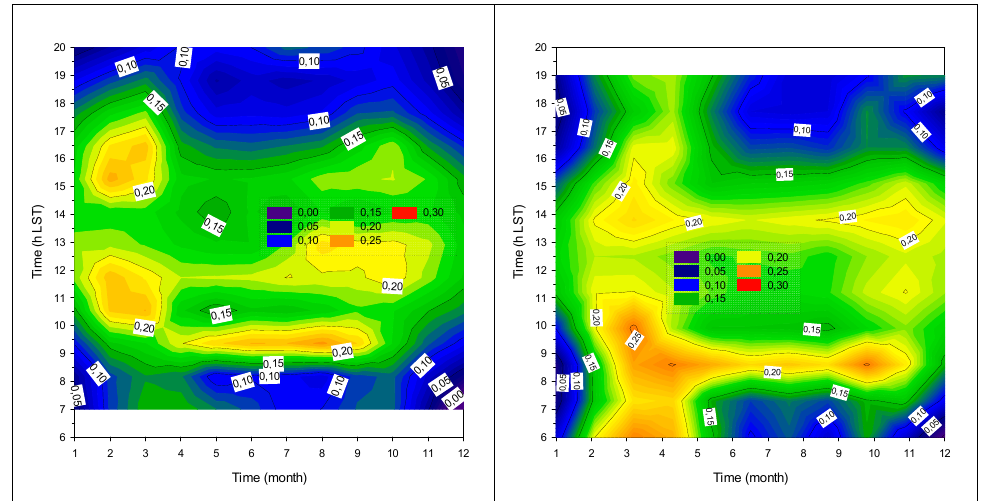
Figure 7. Month-hour diagrams of the T UM values in TATY under clear-sky conditions in climatic zone A: first raw, Irakleio (left), Kalamata (right); climatic zone B: second raw, Agrinio (left), Lesvos (right); climatic zone C: third raw, Alexandroupoli (left), Tripoli (right); climatic zone D: fourth raw: Kastoria (left), Serres (right). The color code refers to the T UM levels, which have been kept in the range 0 < T UM ≤ 0.3. The 06.00–20.00 h LST interval limitation of the graphs is due to the adopted criterion γ ≥ 5°.